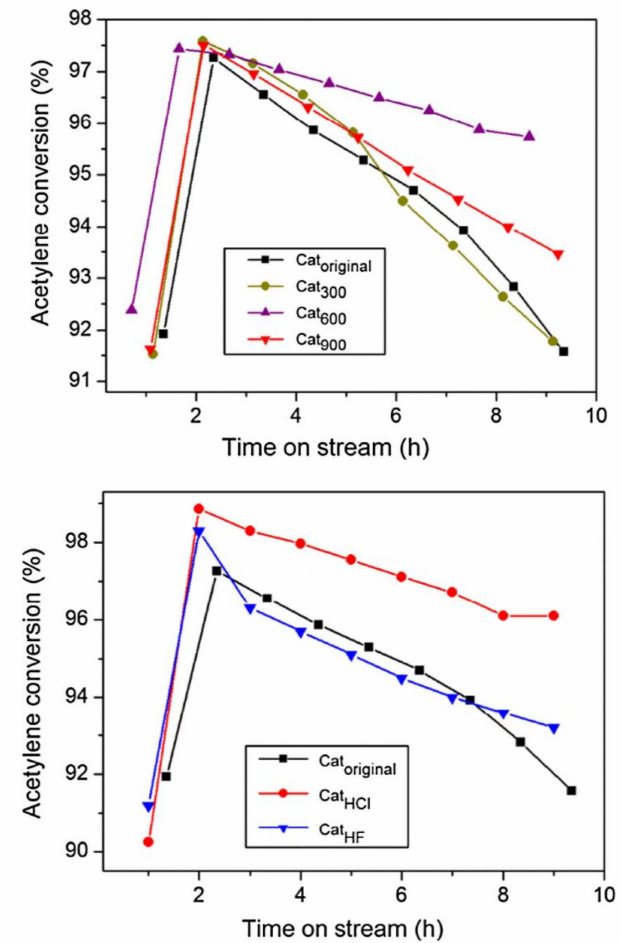
Figure 29. Acetylene conversion by AuCl 3 /C catalysts: temperature activation ( up ) and acid treatment ( down ). Reaction conditions: temperature = 180 ◦ C, C 2 H 2 GHSV = 360 h − 1 , feed volume ratio between HCl and C 2 H 2 = 1.1 (reproduced with permission from [313]. Copyright 2015 Elsevier